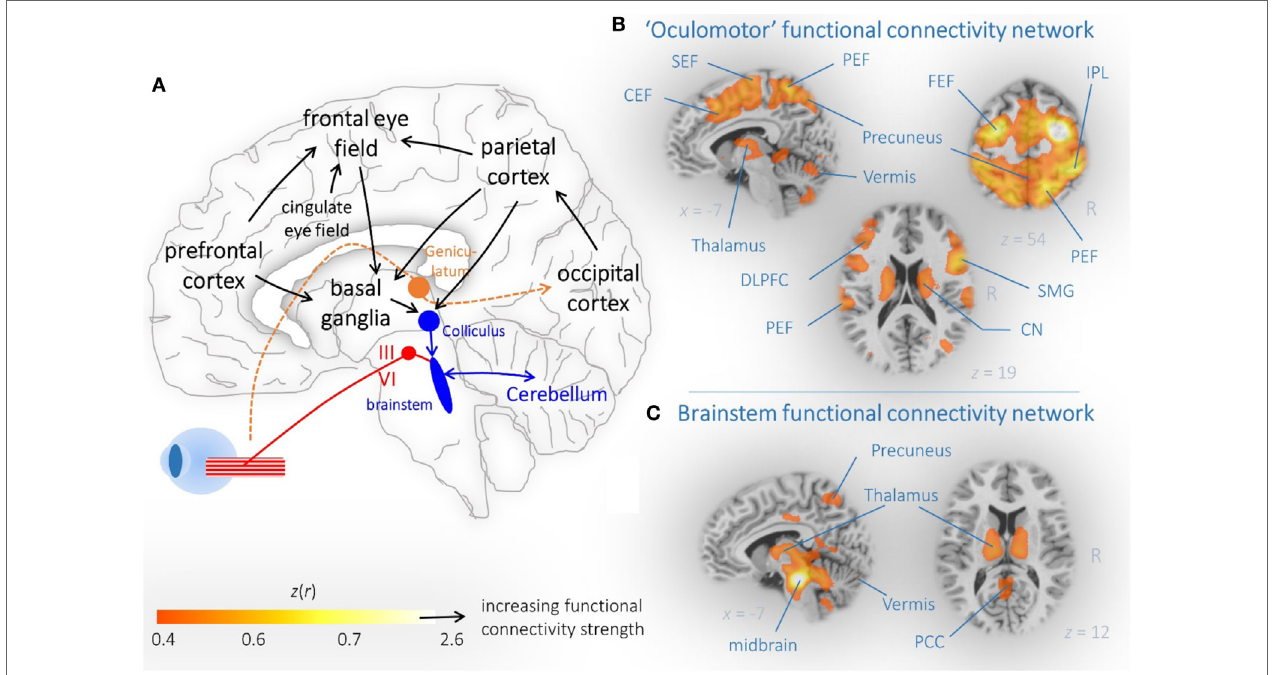
FiGURe 1 | Brain networks associated with eye movement control. (A) Schematic illustration of cortical and subcortical brain regions that are critically involved in eye movement control. Arrows indicated the propagation of information. (B) Dorsal attention and (C) brainstem connectivity network reveal functionally coupled regions that are part of the oculomotor system. (B,C) “Resting-state” functional magnetic resonance imaging connectivity data from 12 healthy controls are shown as representative orthogonal brain section heat maps in the MNI stereotaxic space (19). The z ( r ) values indicate the strength of correlation that indicated functional coupling within the brain maps. Abbreviations: SEF, supplemental eye field; PEF, parietal eye field; CEF, cingulate eye field; IPL, interparietal sulcus; DLPFC, dorsolateral prefrontal cortex; CN, caudate nucleus; SMG, supramarginal gyrus; PCC, posterior cingulate cortex.